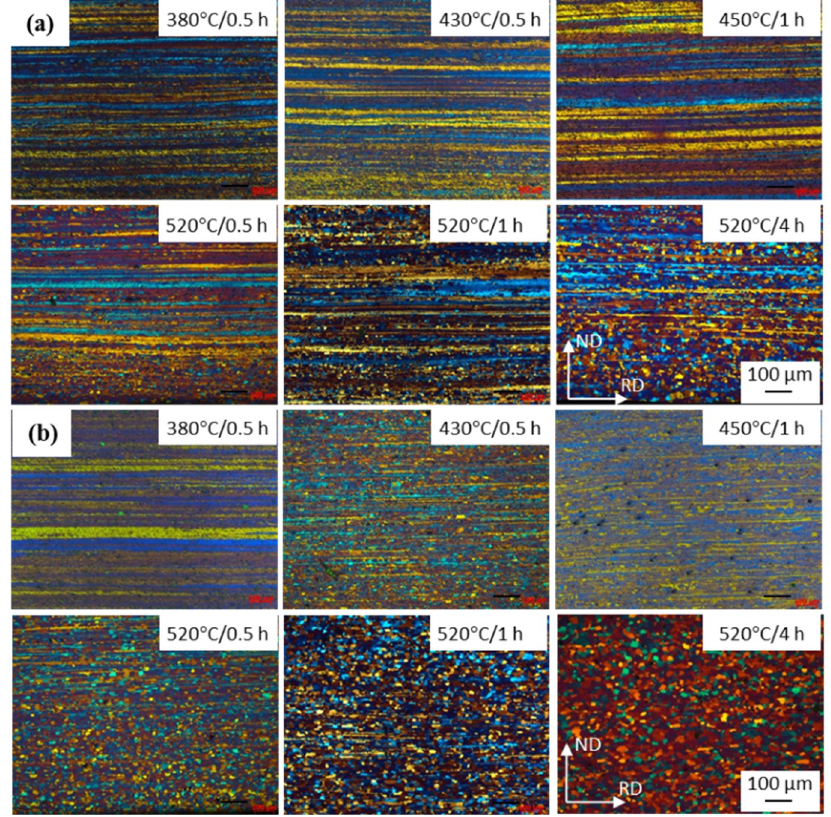
Figure 1. Optical microstructures for the alloys under different annealing temperatures and time: ( a ) Ce-containing alloy; ( b ) Ce-free alloy.